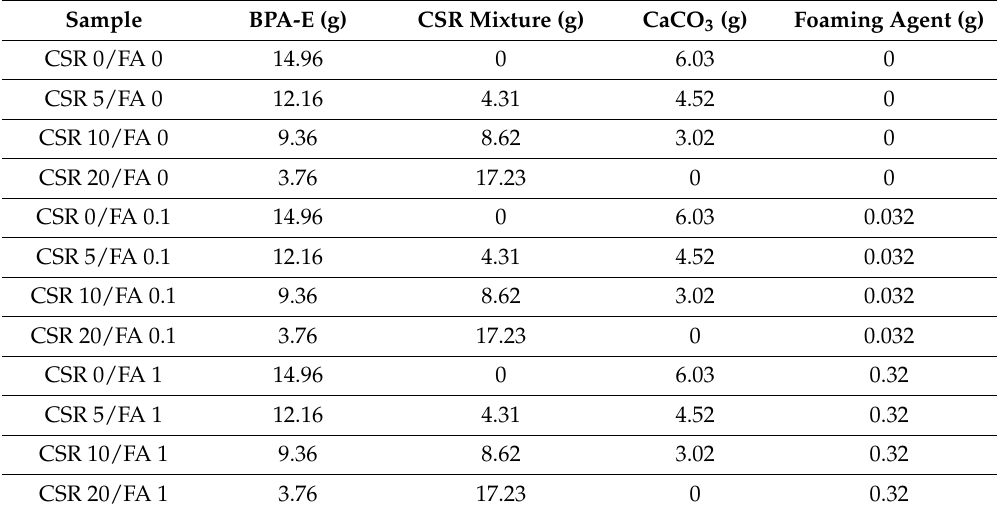
Table 2. Composition of epoxy composites.